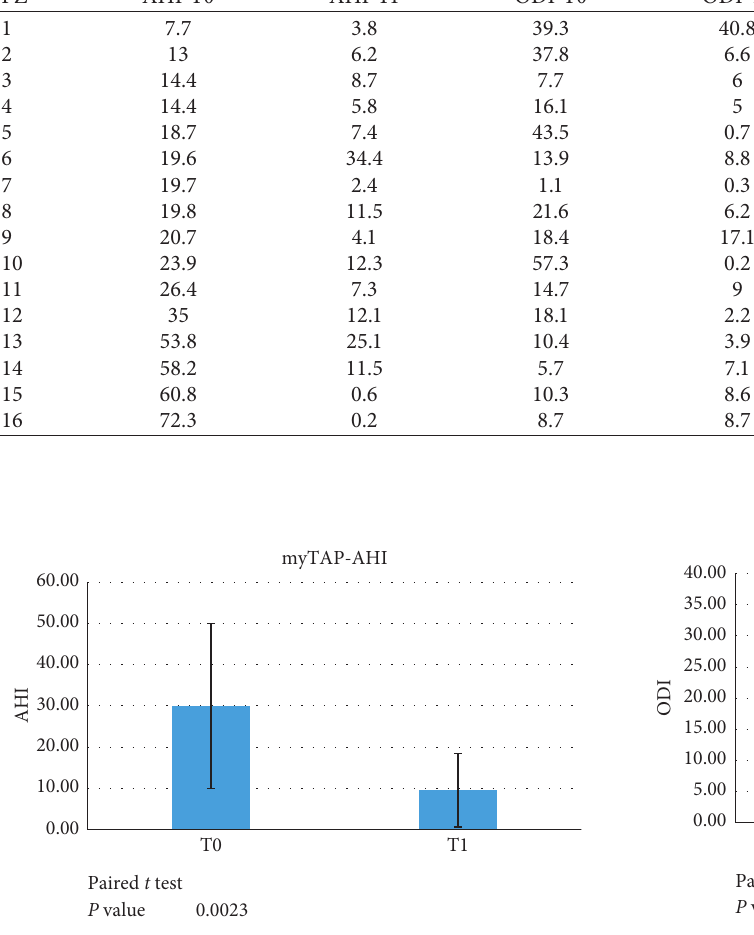
Figure 1: Paired t -test data showed a significant difference between AHI at T0 versus T1 ( p < 0 . 05) when evaluating the use of the myTAP ™ device.